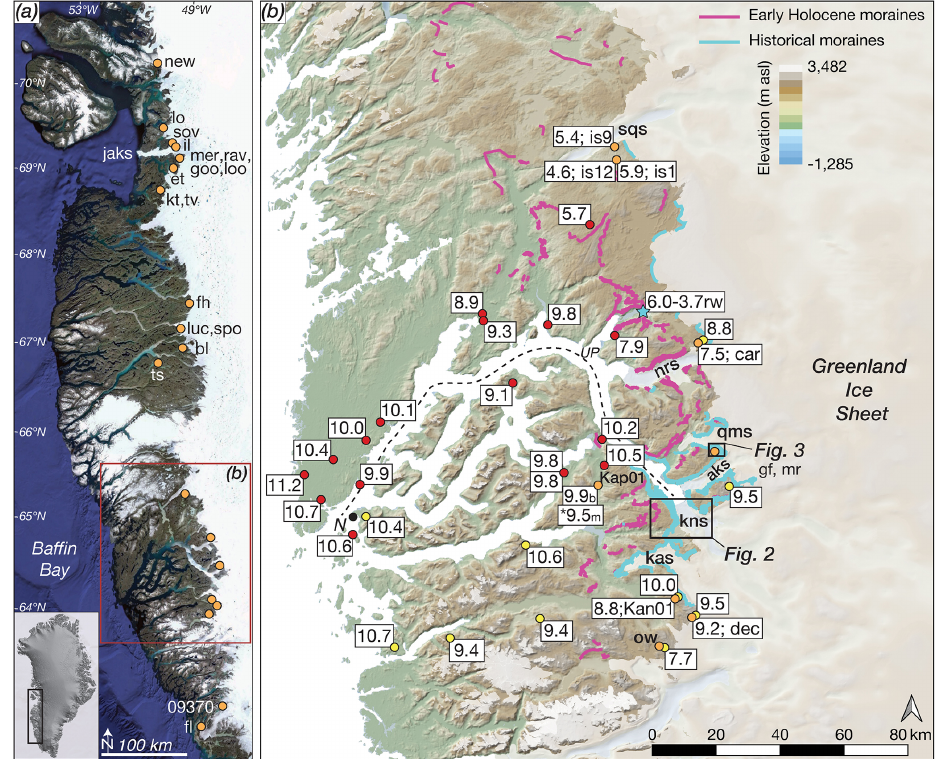
Figure 1. (a) Southwestern Greenland, with the locations of proglacial–threshold lakes discussed in the text. Map data: © Google Maps, Landsat, US Geological Survey; jaks: Jakobshavn Isbræ (Sermeq Kujalleq); new: Newspaper Lake (Cronauer et al., 2015); lo: Lake Lo (Håkansson et al., 2014); sov: South Oval Lake, il: Ice Boom Lake, mer: Merganzer Lake, rav: Raven Lake, goo: Goose Lake, loo: Loon Lake, et: Eqaluit taserssuat (Briner et al., 2010); kt: Kuussuup Tasia, tv: Tininnillik Valley (Kelley et al., 2012); fh: Four Hare Lake (Lesnek et al., 2020); luc: Lake Lucy, spo: Sports Lake (Young and Briner, 2015; Lesnek et al., 2020); bl: Baby Loon Lake, ts: Tasersuaq (Lesnek et al., 2020); 09379, fl: Frederikshåb Isblink (Larsen et al., 2015). (b) The Nuuk (N) region with existing radiocarbon ages (red dots) and 10 Be ages (yellow dots) in ka (before 1950CE) that constrain the timing of regional deglaciation. The Kapisigdlit stade moraines are shown in pink, and historical moraines are in blue (modified from Pearce et al., 2018). For figure clarity we only show the mean deglaciation age at each location without uncertainties; see Table S1 (radiocarbon) and Table S2 ( 10 Be) for details. Also shown are the locations of proglacial– threshold lakes discussed in the text (orange dots) and the location of marine bivalves reworked into the historical maximum (blue star) near Ujarassuit Paavat (up; Weidick et al., 2012; rw indicates reworked). The dotted line marks the flowline used to assess model–data fit in Fig. 18 – is1, is9, and is12 (Levy et al., 2017); car: Caribou Lake, gf: Goose Feather Lake (Lesnek et al., 2020); mr: Marshall Lake (this study); dec: Deception Lake, ow: One-way Lake (Lesnek et al., 2020); Kan01 (Larsen et al., 2015); Kap01 (Larsen et al., 2014 and this study; b: bulk sediments; m: macrofossils). Glaciers are as follows – kns: Kangiata Nunaata Sermia; kas: Kangaasarsuup Sermia; aks: Akullersuup Sermia; qms: Qamanaarsuup Sermia; nrs: Narsap Sermia; sqs: Saqqap